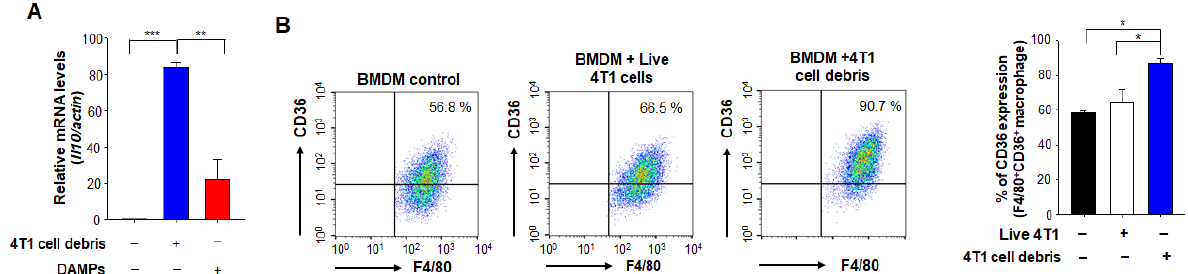
Figure 3. Effects of PTX-generated tumor cell debris on expression of CD36 in BMDMs. ( A ) The Il10 mRNA levels of BMDMs incubated for 8 h with or without 4T1 cell debris or DAMPs from 4T1 tumor cell debris were analyzed by qPCR. ( B ) The expression of CD36 on macrophages co-cultured with viable 4T1 cells or 4T1 tumor cell debris for 24 h was analyzed by flow cytometry. *, **, *** Significantly different between groups compared (* p < 0.05; ** p < 0.01; *** p < 0.001).